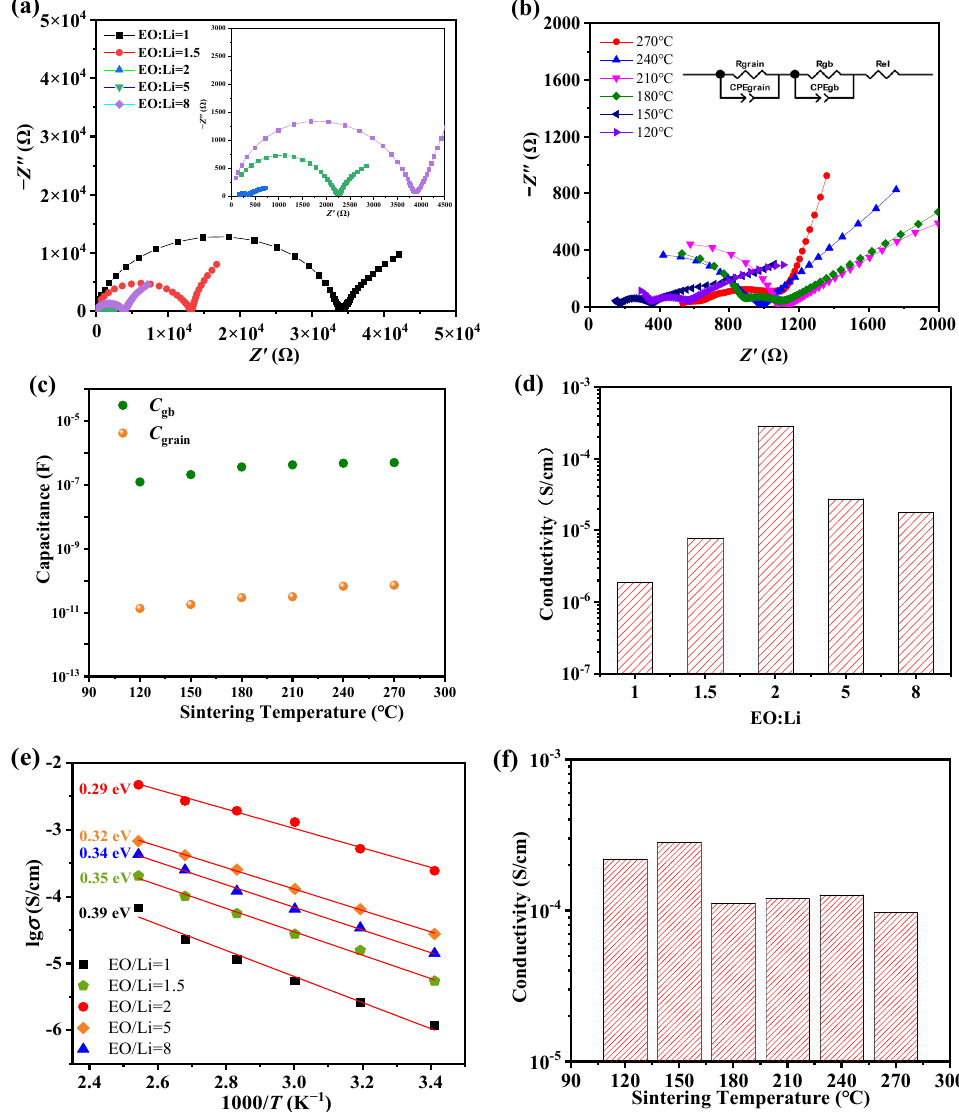
Figure 2. The Nyquist plots of ( a ) cold-sintered LLZTO-PEO x -LiTFSI composite electrolytes and ( b ) cold-sintered LLZTO-PEO 2 -LiTFSI composite electrolyte with different sintering temperatures, and the inset shows the equivalent circuit. ( c ) Capacitance versus cold sintering temperatures for the individual R-CPE elements of LLZTO-PEO 2 -LiTFSI. ( d ) The ionic conductivity of cold-sintered LLZTO-PEO x -LiTFSI composite electrolytes. ( e ) Arrhenius curves of cold-sintered LLZTO composites with various EO:Li. ( f ) Cold-sintered LLZTO-PEO 2 -LiTFSI composite electrolyte with different sintering temperatures.